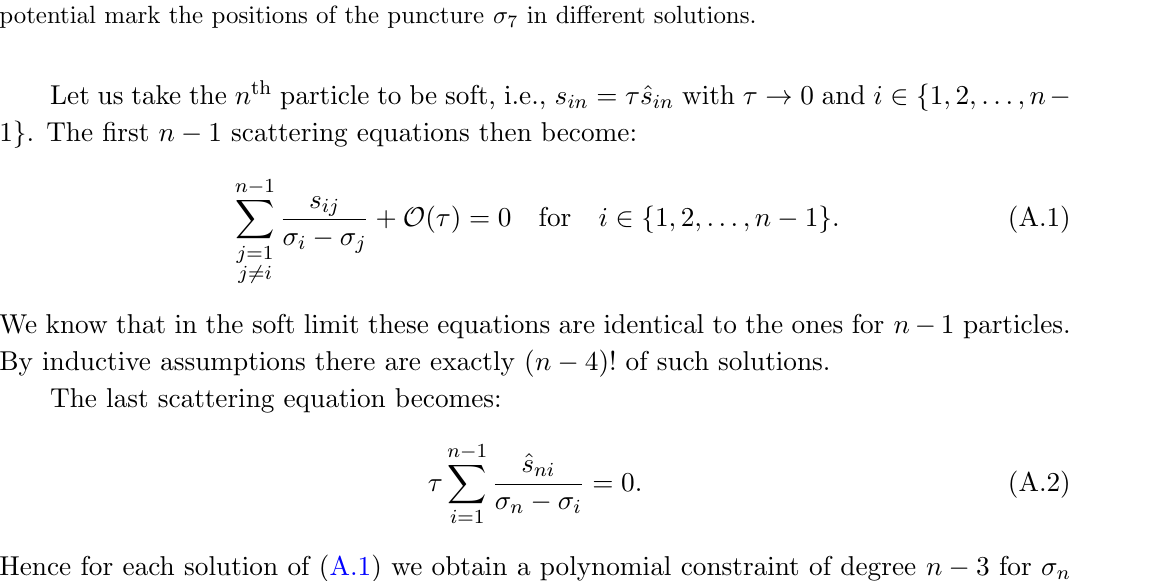
Figure 3 . Example of the potential, V ( (cid:27) 7 ), for the soft particle with label 7. The minima of the potential mark the positions of the puncture (cid:27) 7 in di(cid:11)erent